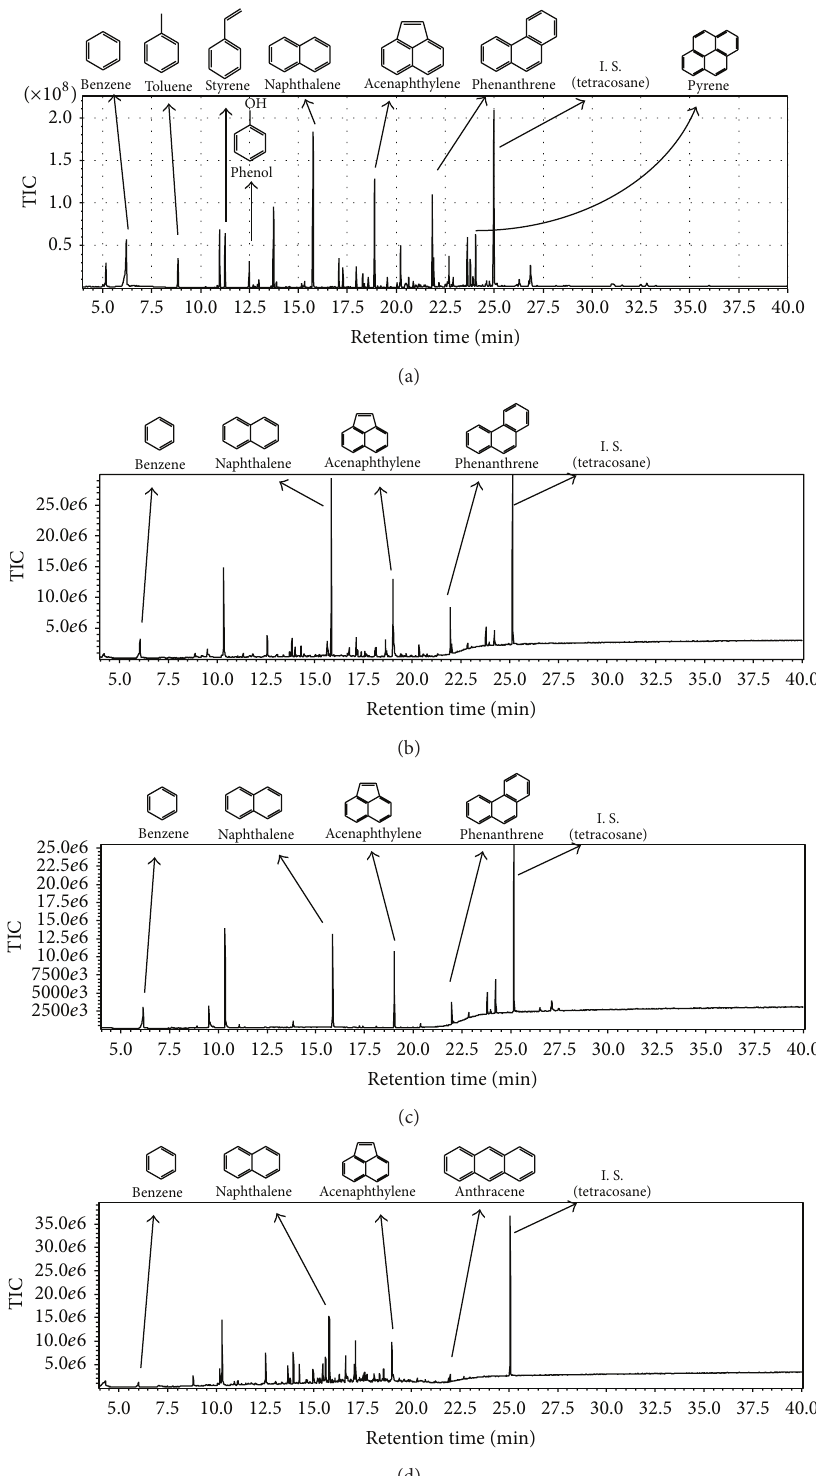
Figure 9: TIC of pyrolysis oils obtained from of Japanese cedar wood meal/catalyst (1: 1 w/w) mixtures pyrolyzed at 800 ∘ C: (a) without catalyst [10], (b) Fe 3 O 4 , (c) TiO 2 , and (d)